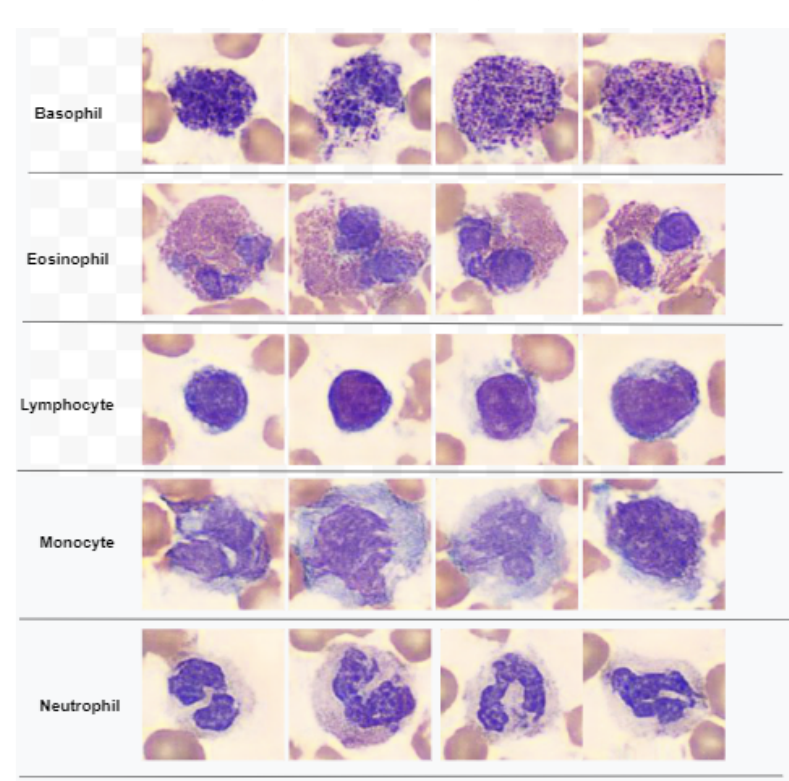
Figure 2. Samples of WBC images of dataset [34] used in this work. Figure 2. Samplesof WBC images of dataset used in this work.